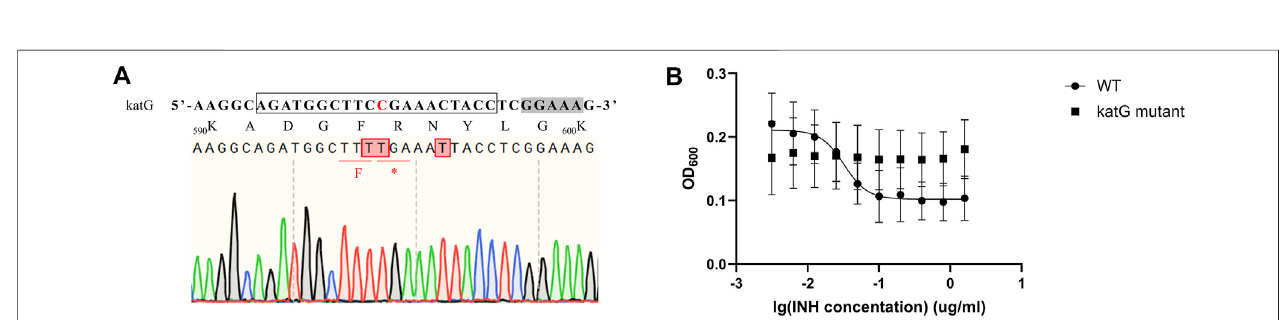
FIGURE 5 | katG inactivation confers high-level resistance to INH. (A) Edited katG gene loci were analyzed by deep sequencing. sgRNA sequence is boxed and a greyboxindicatesthePAMsequence.Editedcytidinesandaminoacidsarehighlightedinred. (B) MIC 50 valuesofwild-typeH37Raand katG mutant.Theseexperiments were carried out in triplicate. Data are given as mean values and standard deviations.